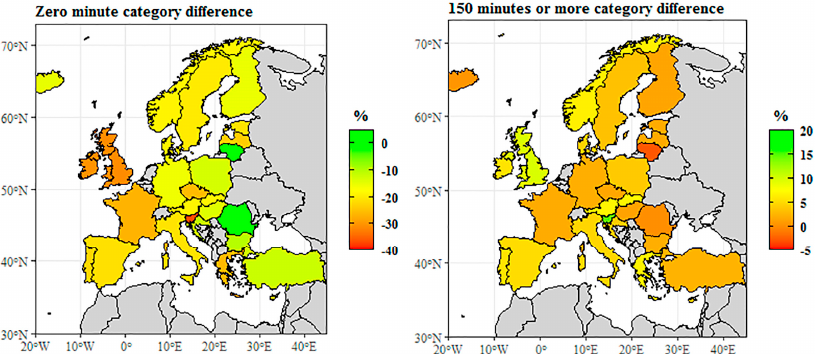
Figure 3. Time spent on health—enhancing (not work—related) aerobic physical activity by educational attainment level difference (male—female, in %, 2014). Note: Educational attainment level according to the International Standard Classification of Education (ISCED 2011), where levels between 0 and 2 means less than primary, primary, and lower secondary education and levels between 5 and 8 means tertiary education. Source: [136].